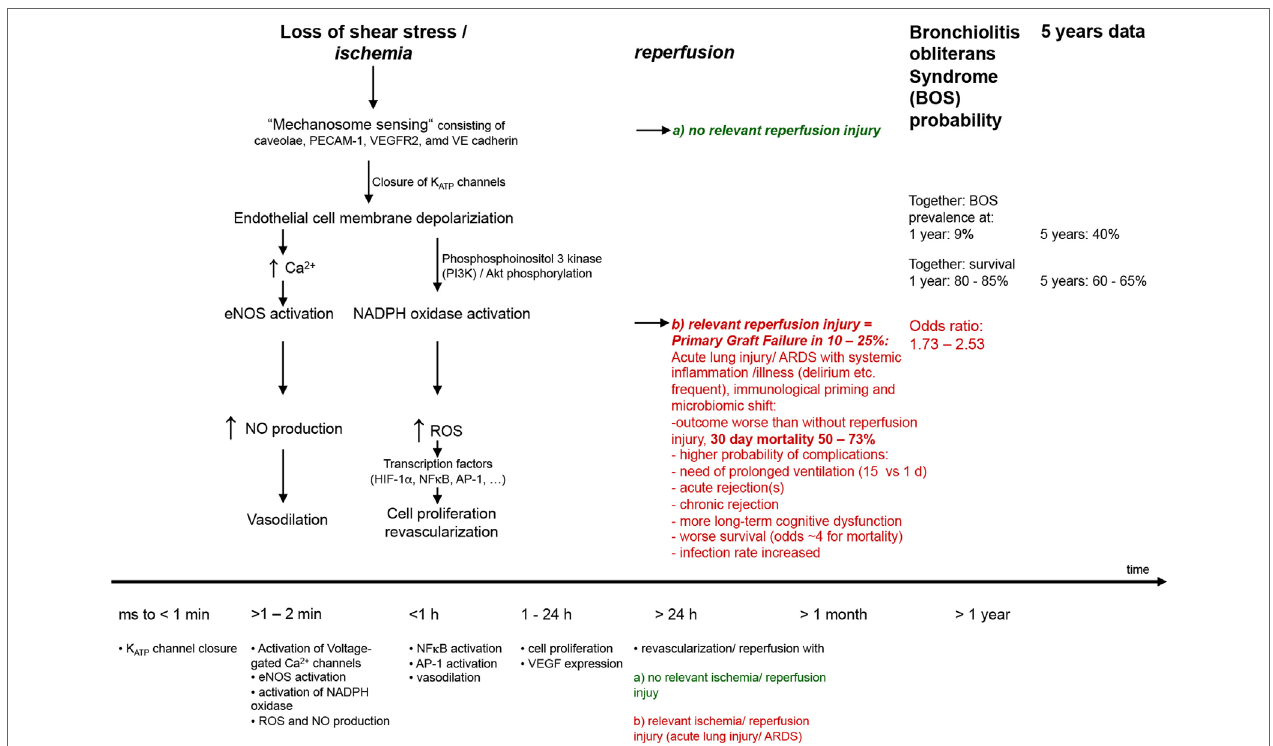
FigURe 9 | Pathophysiology and biological significance of pulmonary reimplantation response after lung transplantation (491–501). Adapted from Chatterjee et al (499), Whitson et al (496), Hartert et al (501), Basseri et al (498), Bharat et al (495), Bharat et al (497), Christie et al (492, 493), Huang et al (502), and King et al